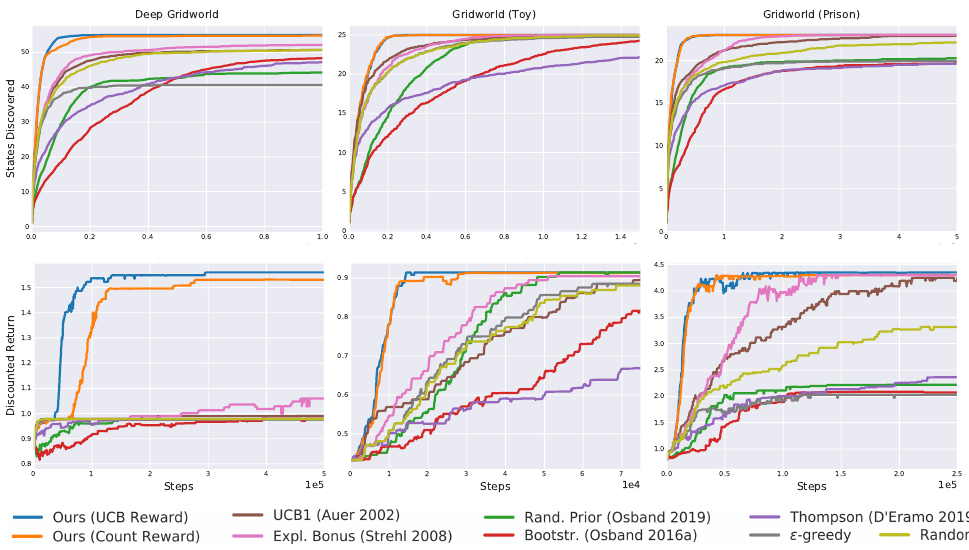
Figure 27. Results with stochastic transition function on three of the previous MDPs. Once again, only our algorithms visit all states and learn the optimal policy within steps limit in all MDPs, and their performance is barely affected by the